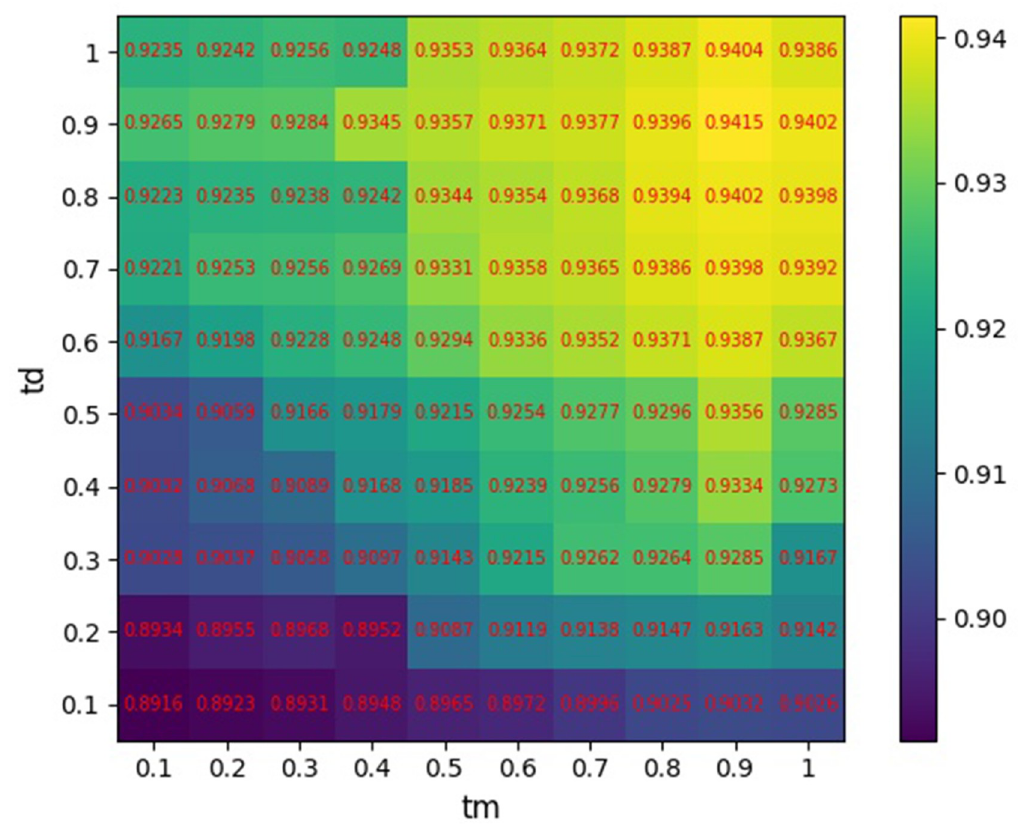
Fig 7. AUCs of 5-CV at different values of tm and td